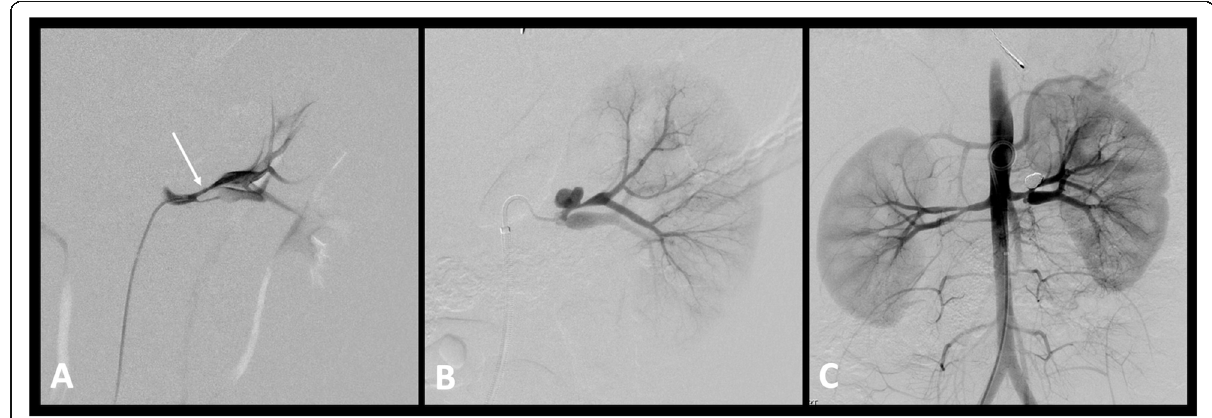
Fig. 6 Pseudoaneursym. a Left renal artery angiogram demonstrating early bifurcation with tight long segment stenosis of both renal artery branches (arrow). b Follow up 2 month angiogram demonstrates a pseudoaneurysm at the site of angioplasty of the upper renal artery branch, treated successfully with coil embolization ( c )